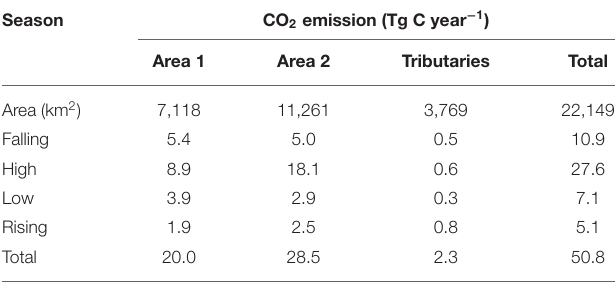
TABLE 3 | Seasonal CO 2 emissions in the Amazon River channel considering different areas. Season